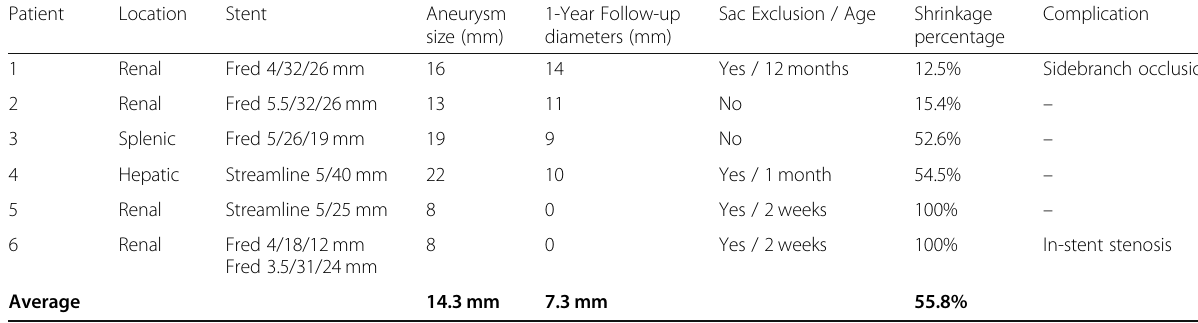
Table 2 Aneurysm details, flow-diverter stents sizes, results and complications